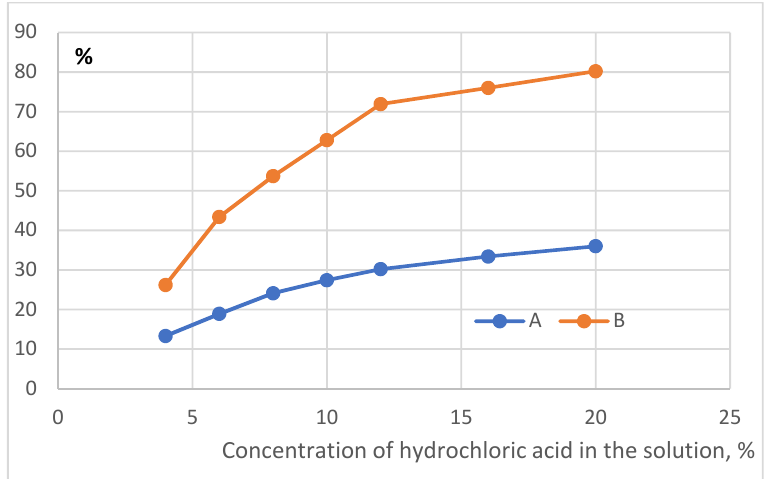
Figure 5. Average Iron extraction (%) without mechanical activation (A) and with mechanical activation (B).